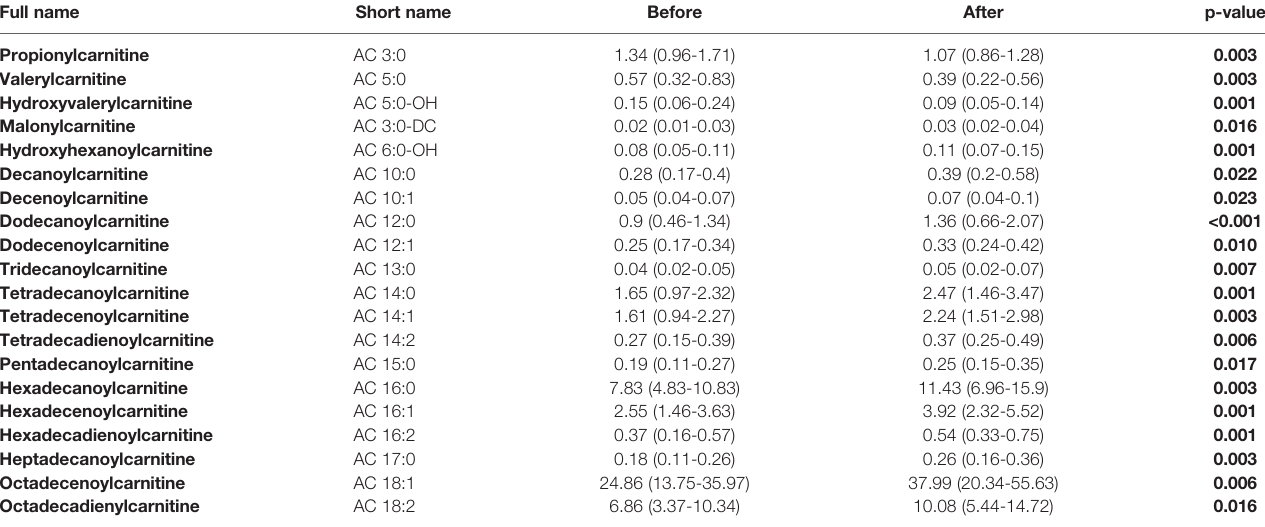
TABLE 2 | Detected signi fi cant differences in concentrations of measured ACs before and after the exercise intervention in all studied